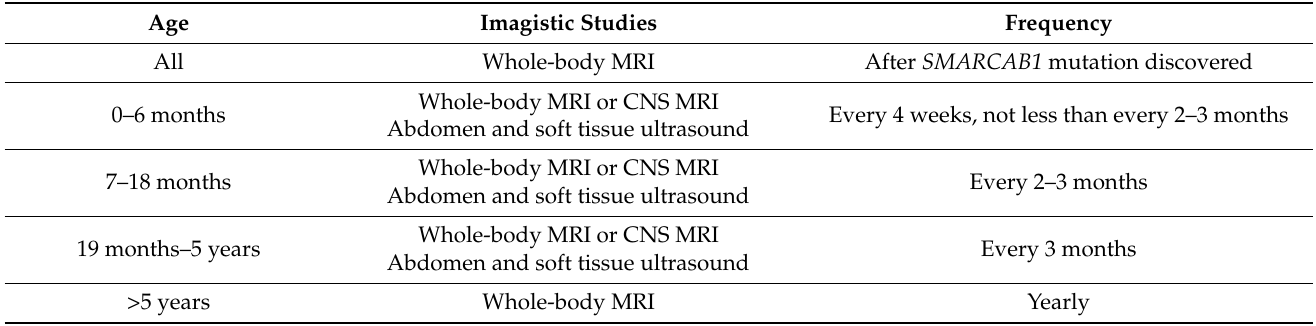
Table 1. Frequency of MRI and/or ultrasound examination in RTPS 1 and RTPS 2 based on the age of the